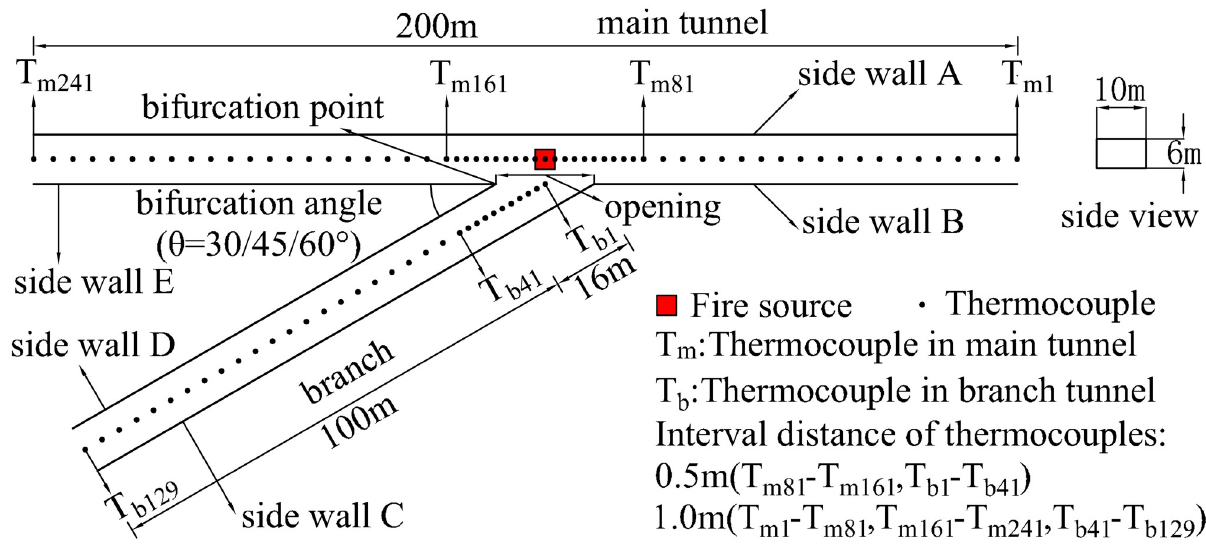
Fig 1. Schematic diagram of bifurcation tunnel geometric model.